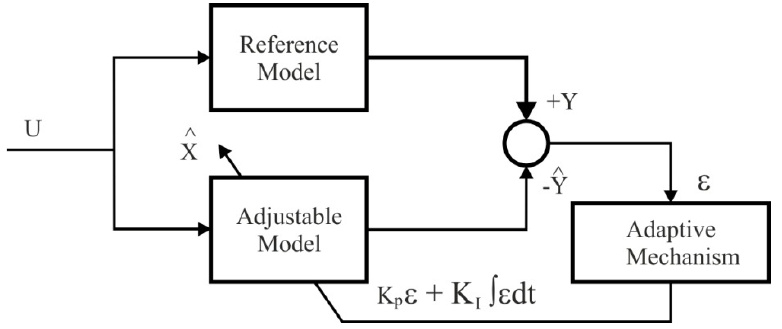
Figure 19. Basic configuration of a MRAS